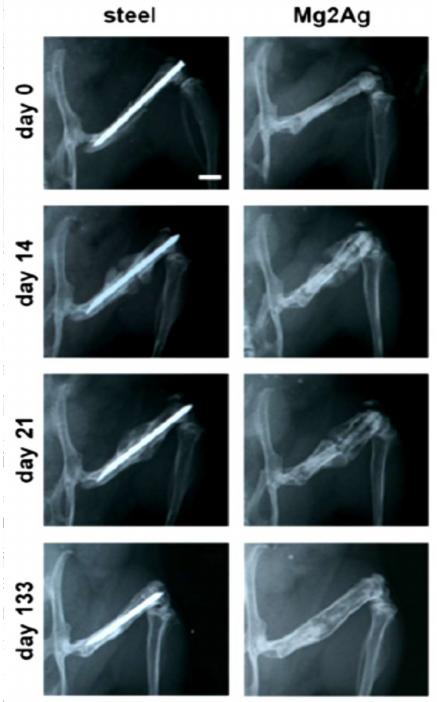
Figure 6. X-ray images to determine degradation of intramedullary Mg2Ag wires during 133 days in mice compared to a steel pin (scale bar = 5 mm), reproduced with permission from [113], Elsevier, 2016.